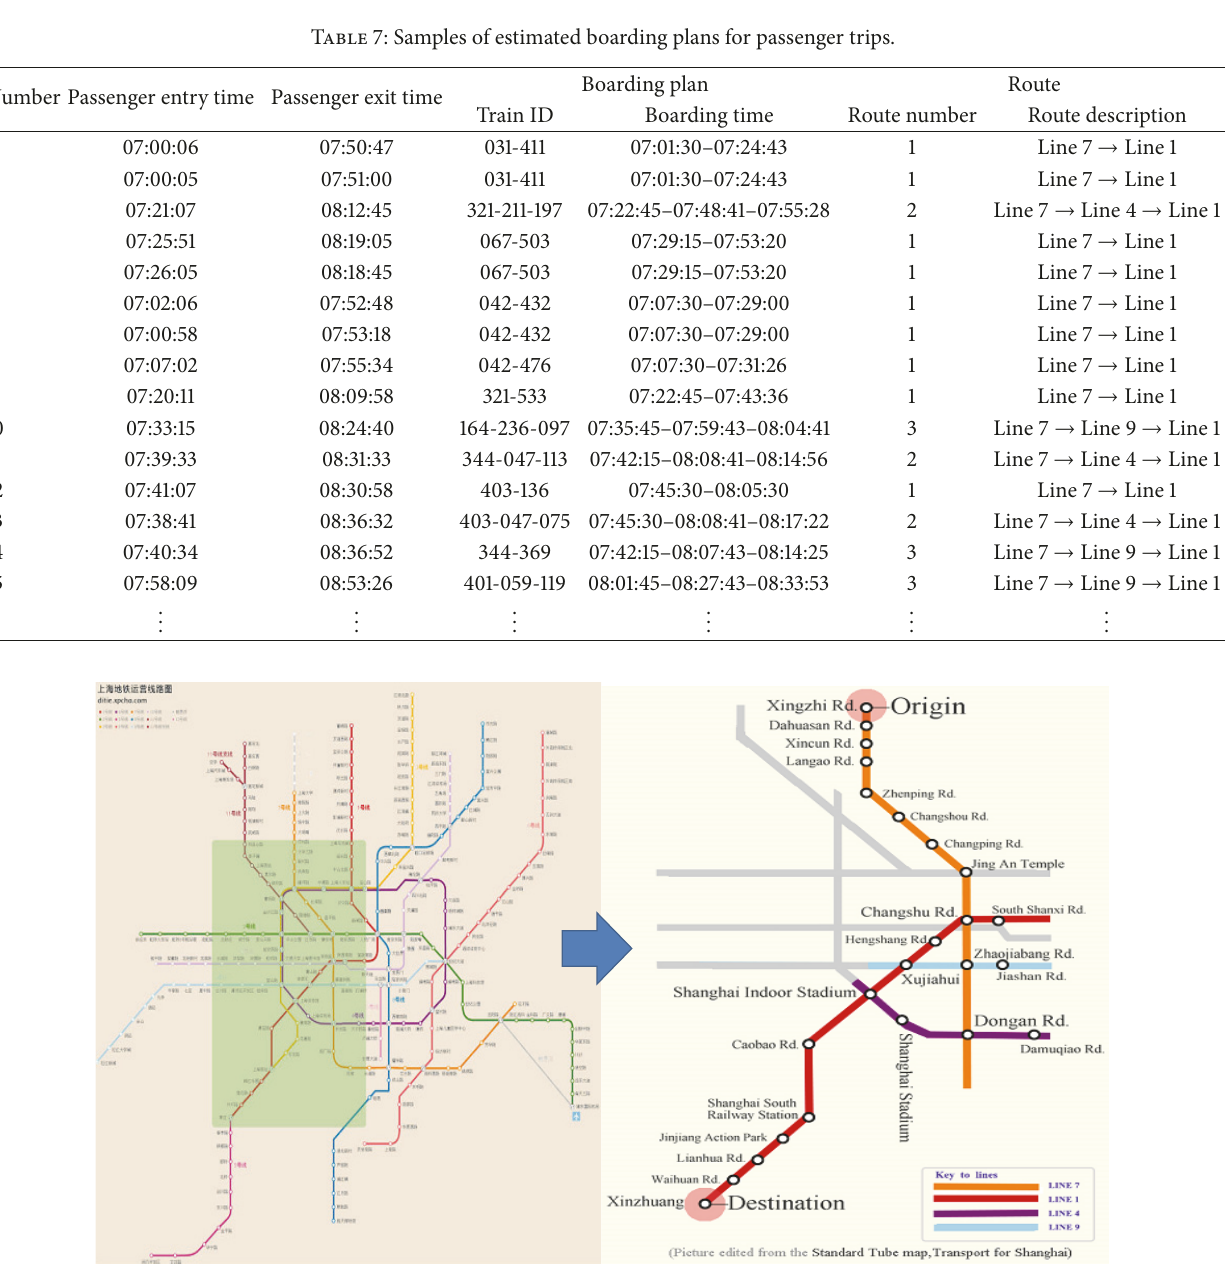
Figure 7: Rail network connecting the test O-D pair (Xingzhi Rd. →